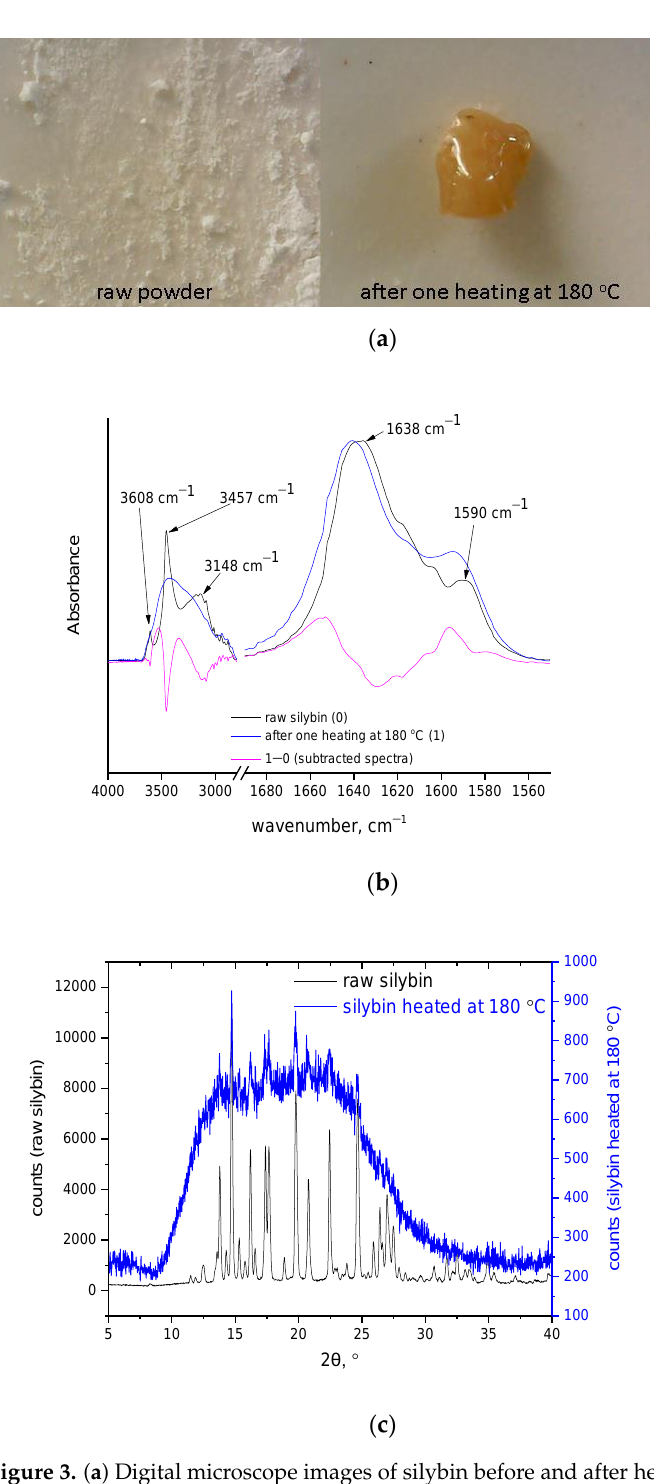
Figure 3. ( a ) Digital microscope images of silybin before and after heating to 180 °C, ( b ) FTIR spectra of raw and heated silybin samples and their subtracted spectra, and ( c ) XRD patterns of silybin before and after being heated to 180 °C.